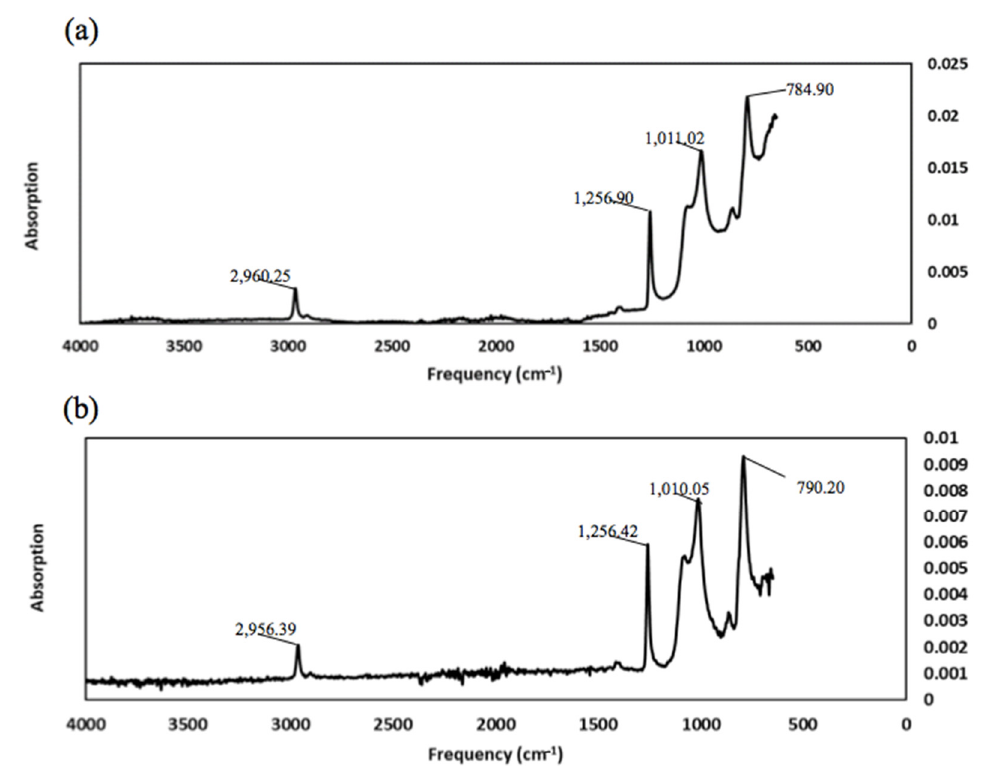
Figure 5. ( a ) The absorption properties of the SWCNT fabricated in this work and ( b ) the MWCNT fabricated in this work.